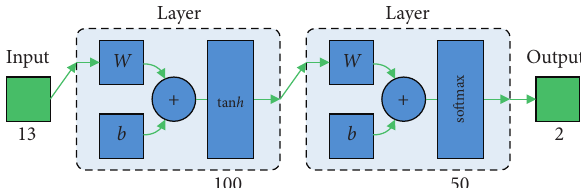
Figure 16: Safety state of buses model based on BP neural